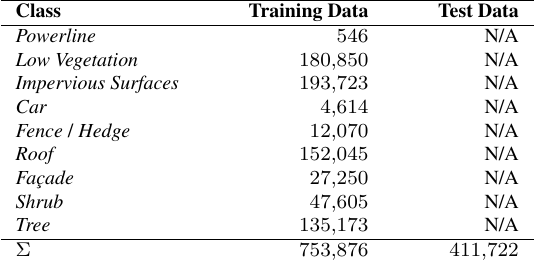
Table 1. Number of 3D points per class for the Vaihingen Dataset . Note that the reference labels are only provided for the training data and not available for the test data.